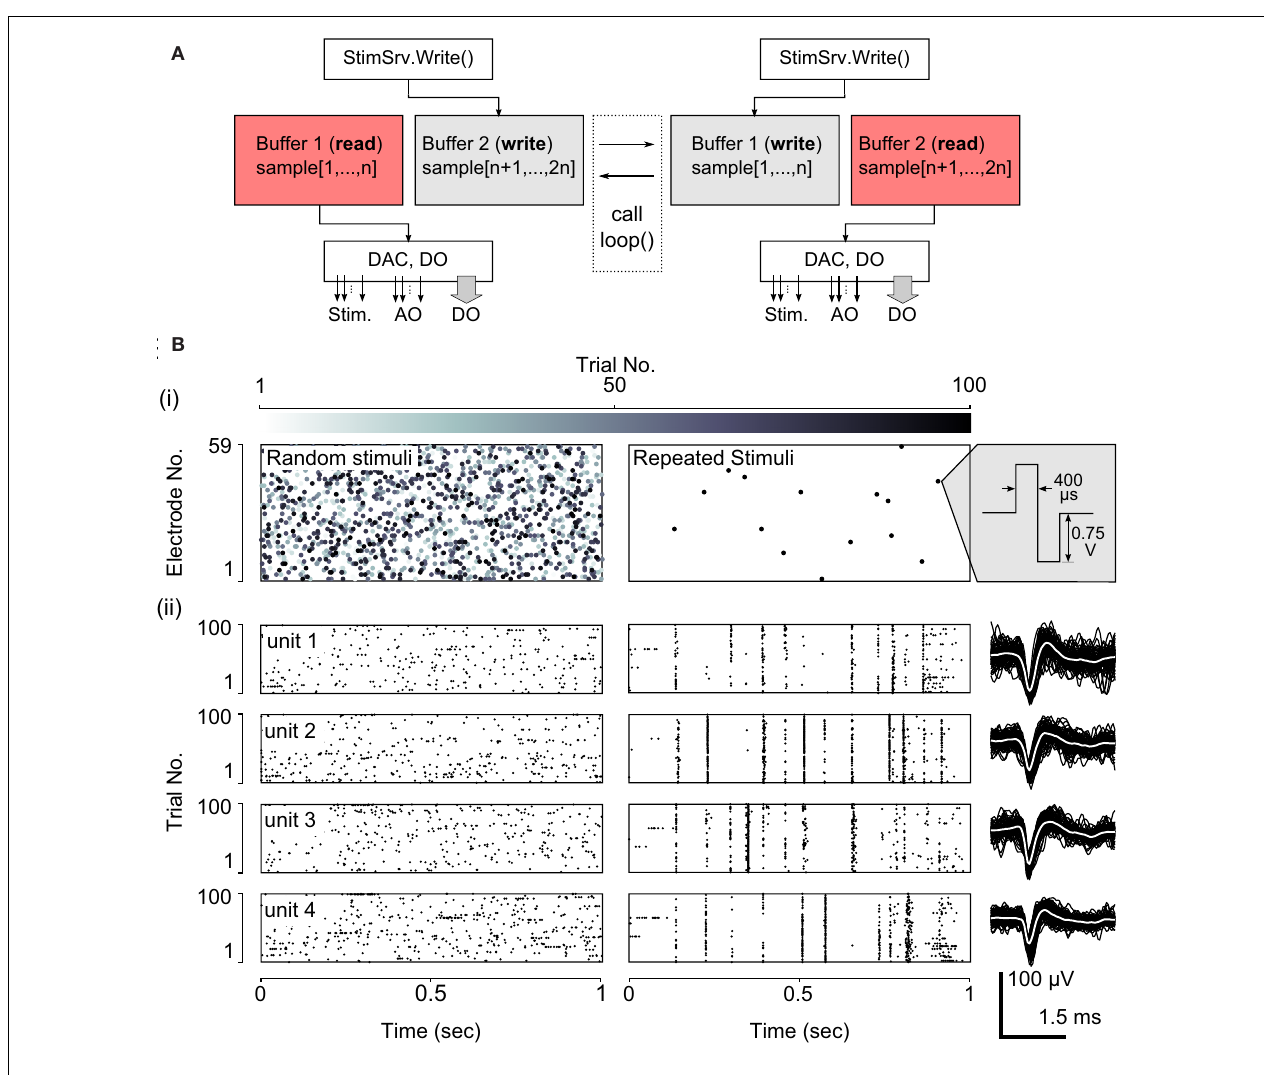
open-loop stimulus protocol using StimSrv . (i) 100, 1s Poisson sequences of electrical stimuli (left) and a single repeated Poisson sequence (right), were delivered to a dissociated cortical network (biphasic, voltage controlled, ± 0.75V, 800 µ s period). Stimulus rasters are shown using a gray-scale to indicate the trial number. For repeated stimuli, stimulus points are overlaid since stimulus delivery is clock-synchronized with the acquisition subsystem. (ii) Rastergrams of 4 units are shown below each stimulus raster, across trials. Example waveforms for each of the 4 units are shown to the